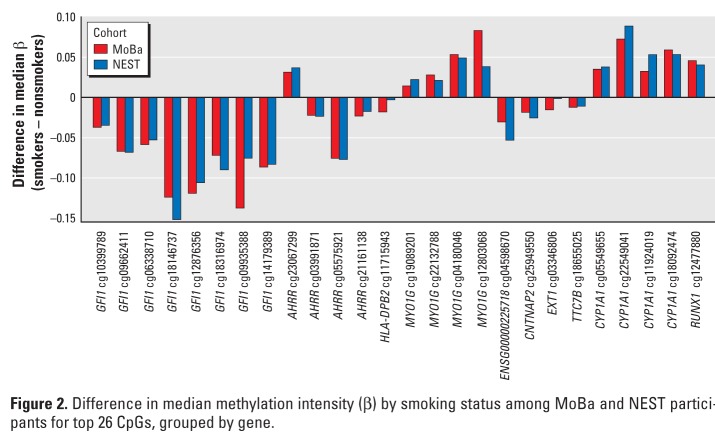
Difference in median methyla­tion intensity (β) by smoking status among MoBa and NEST participants for top 26 CpGs, grouped by gene.